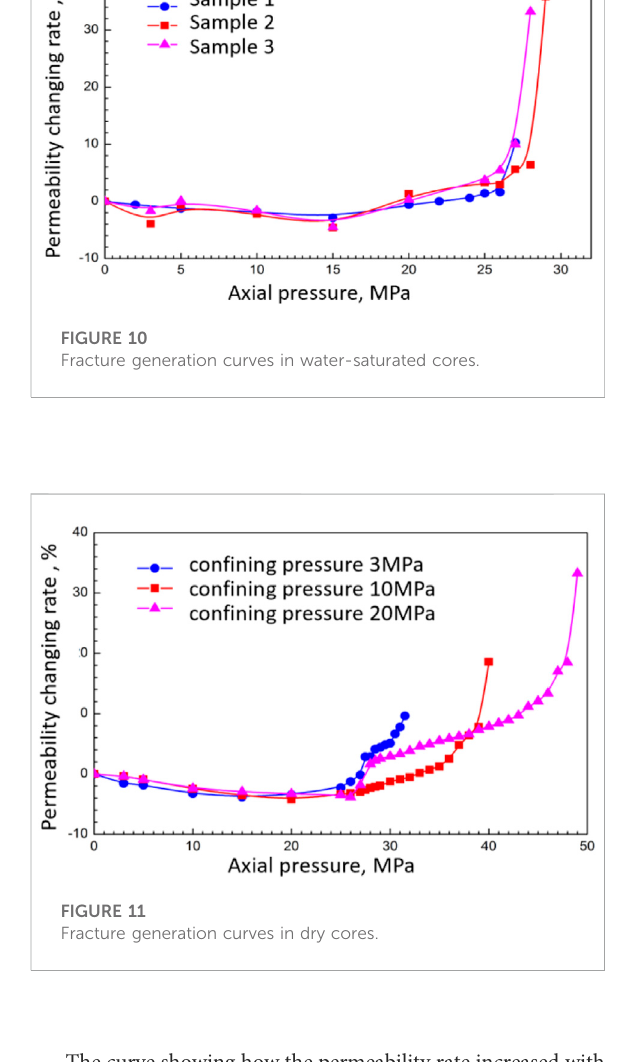
The curve showing how the permeability rate increased with axial pressure during parallel core experiments is shown in Figure 9. When axial pressure dropped below 20 MPa, the rock matrix was compressed under stress. Along with the increase in axial pressure, the area of gas fl ow channels was reduced, and the gas permeability decreased, which was a stress-